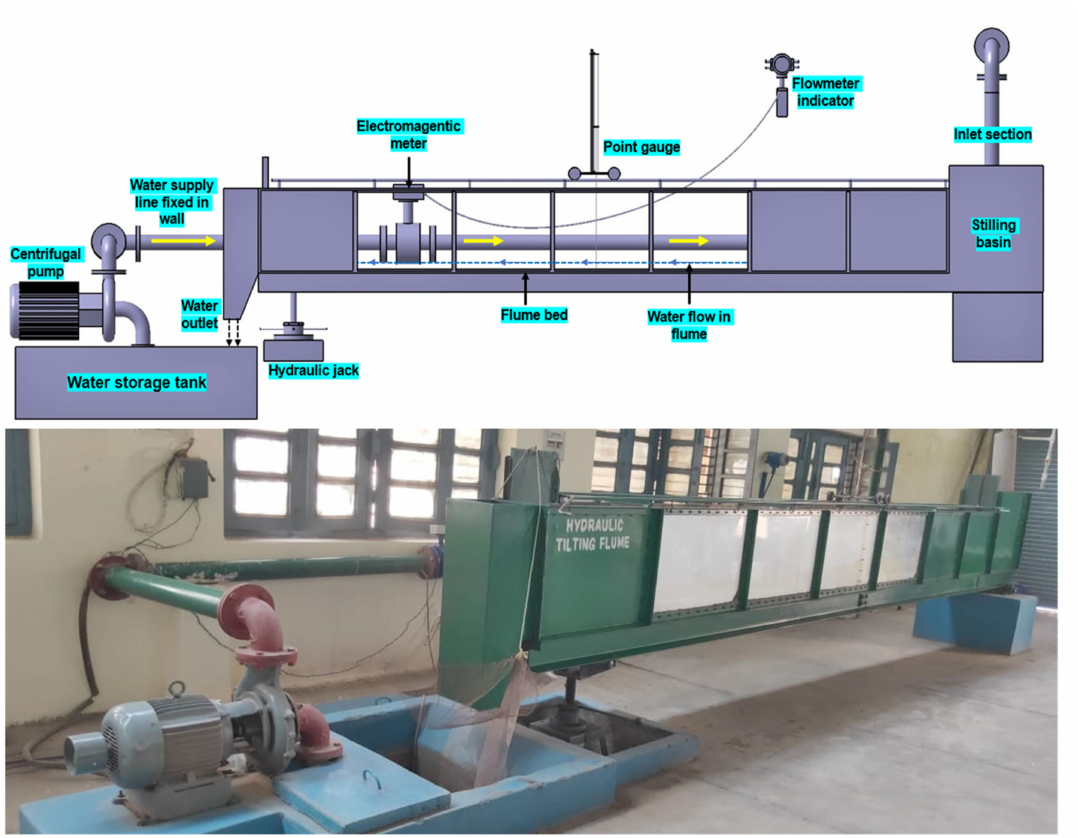
Figure 1. Experimental setup of the hydraulic flume; schematic presentation ( top part ) and lab view ( lower part